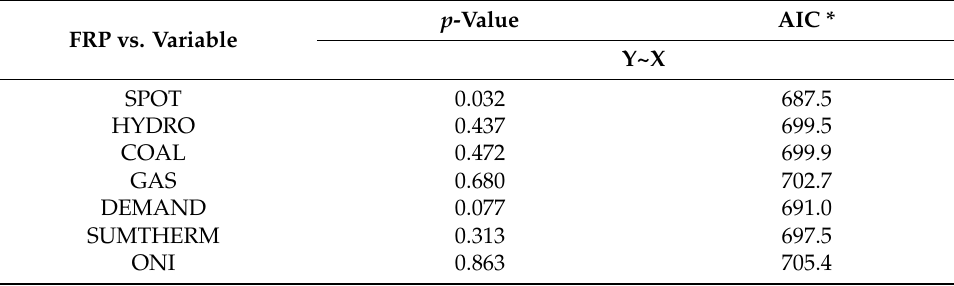
Table 3. Granger causality test for the series differentiated at twelve